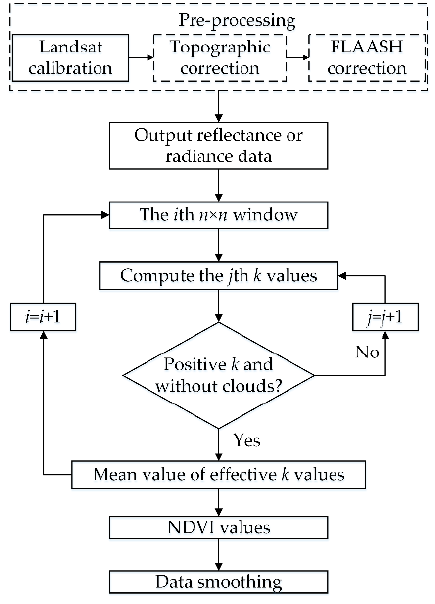
Figure 4. The flowchart of the algorithm proposed in this paper.